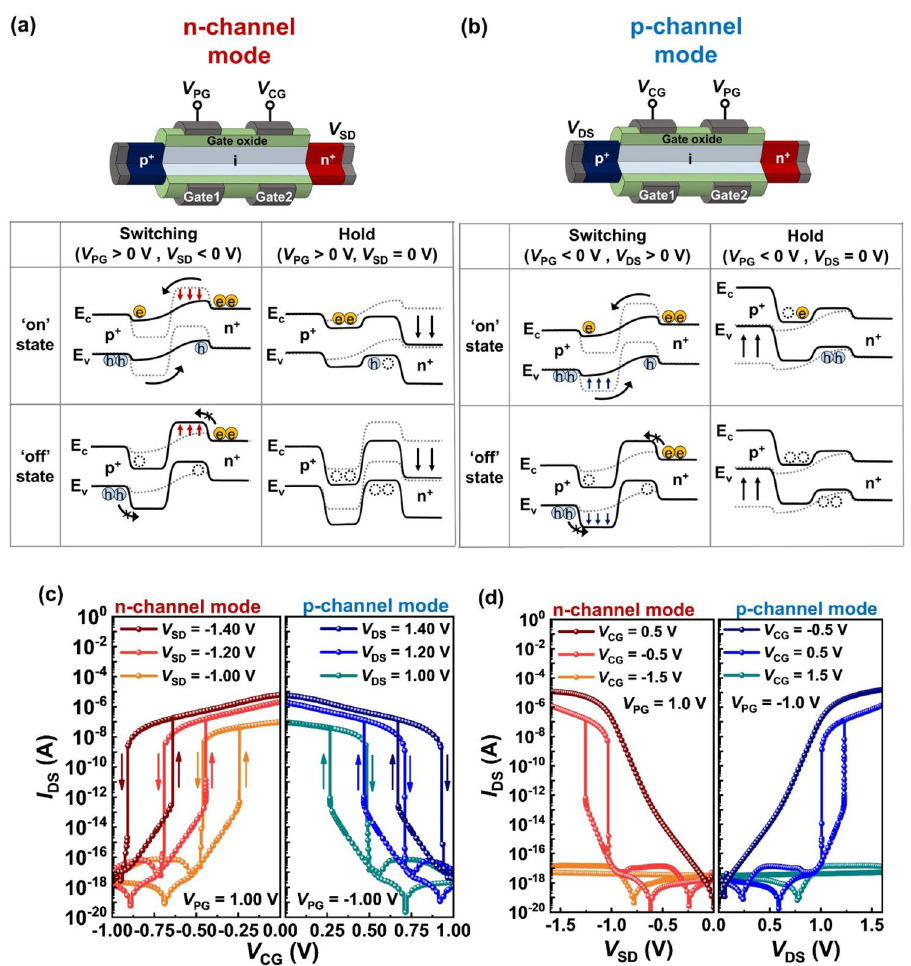
Figure 1. The operation mechanism of the reconfigurable double-gated feedback field-effect transistor (DG FBFET). The schematic illustration of the reconfigurable switching and holding operations in the ( a ) n- and ( b ) p-channel modes. ( c ) Transfer and ( d ) output characteristics for the n- and p-channel